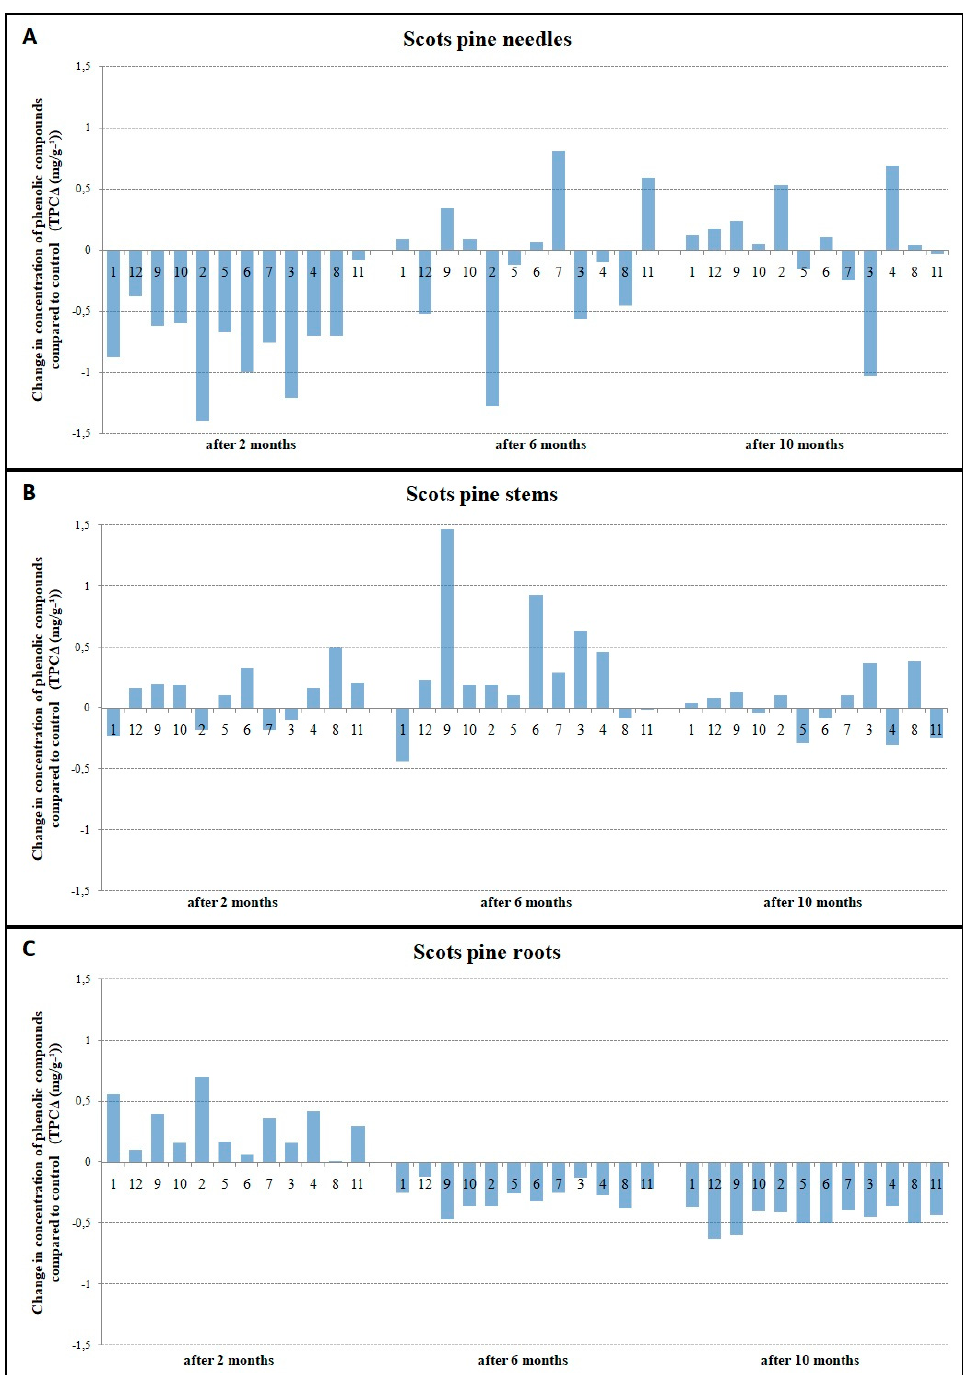
Figure 5. Change in concentration of total phenolic compounds (TPC Δ ) two, six, and ten months after inoculation compared to the control group of 12 Scots pine half-sib families: ( a ) TPC Δ in needles; ( b ) TPC Δ in stems and ( c ) TPC Δ in roots.